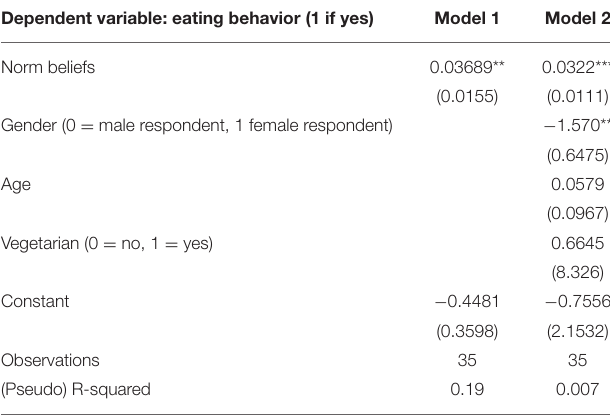
TABLE 1 | Probit regression analysis including control variables (Study 1). TABLE 2 | Probit regression on non-vegetarians ( n = 133) including control variables (Study